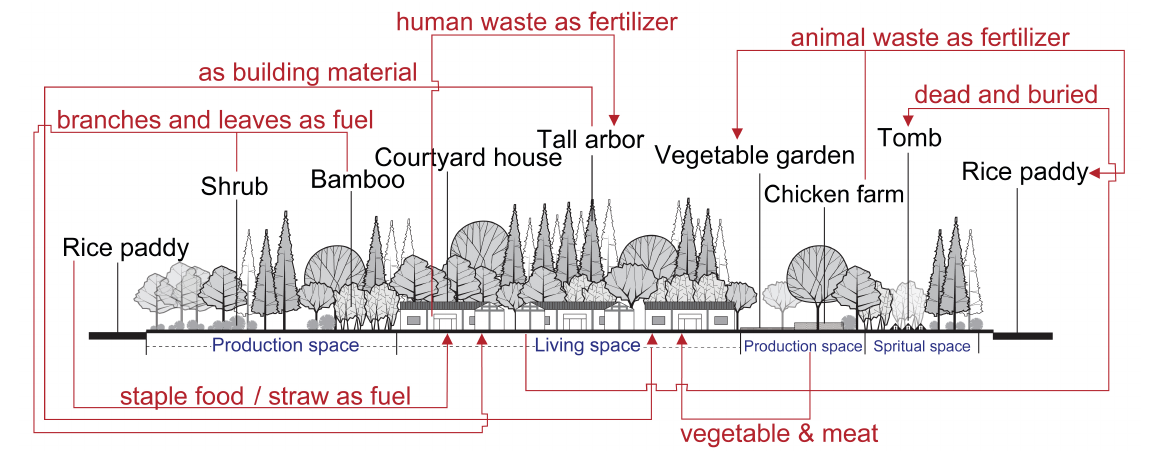
Figure 2 Example of a traditional human–land relationship in villages on the Chengdu Plain, China (Source: Shi 2013)